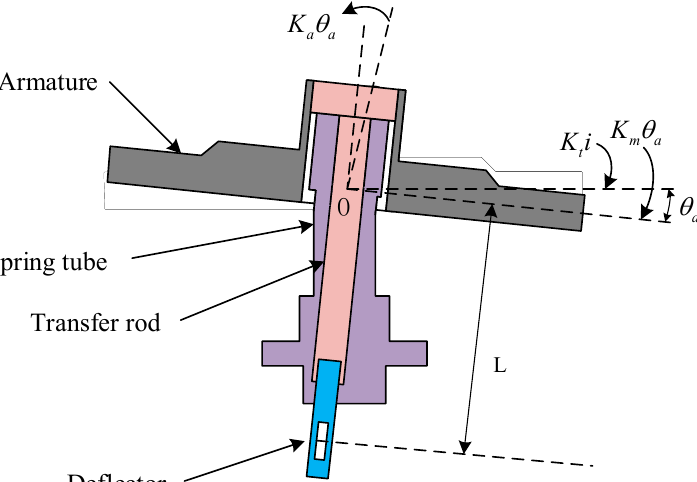
Figure 3. Armature component rotation diagram.